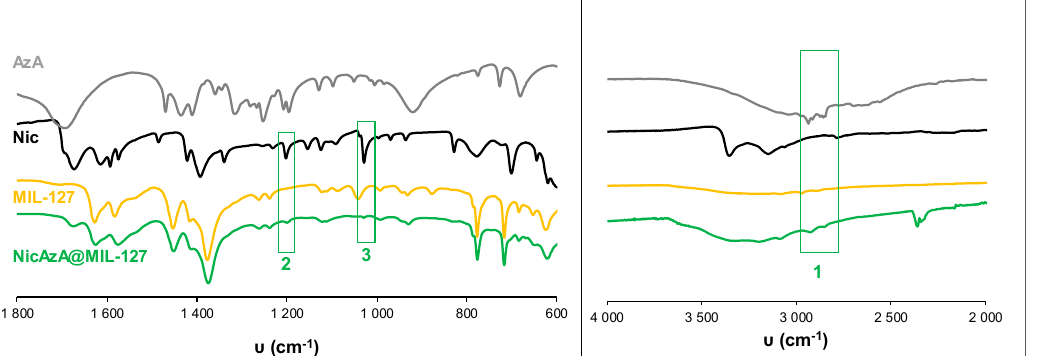
Figure 6. FT-IR spectra of empty MIL-127 and drugs-loaded NicAzA@MIL-127. The spectra of free Nic and AzA have been included for comparison. FT-IR spectroscopic analysis clearly showed the presence of Nic and AzA into the NicAzA@MIL-127 loaded matrix: Nic ν (C-NH 2 ) (2), Nic δ (C-H) (3) bands. The inset shows a spectra magnification with the AzA ν (C-H) – ν (OH) (1) band [70–72] .